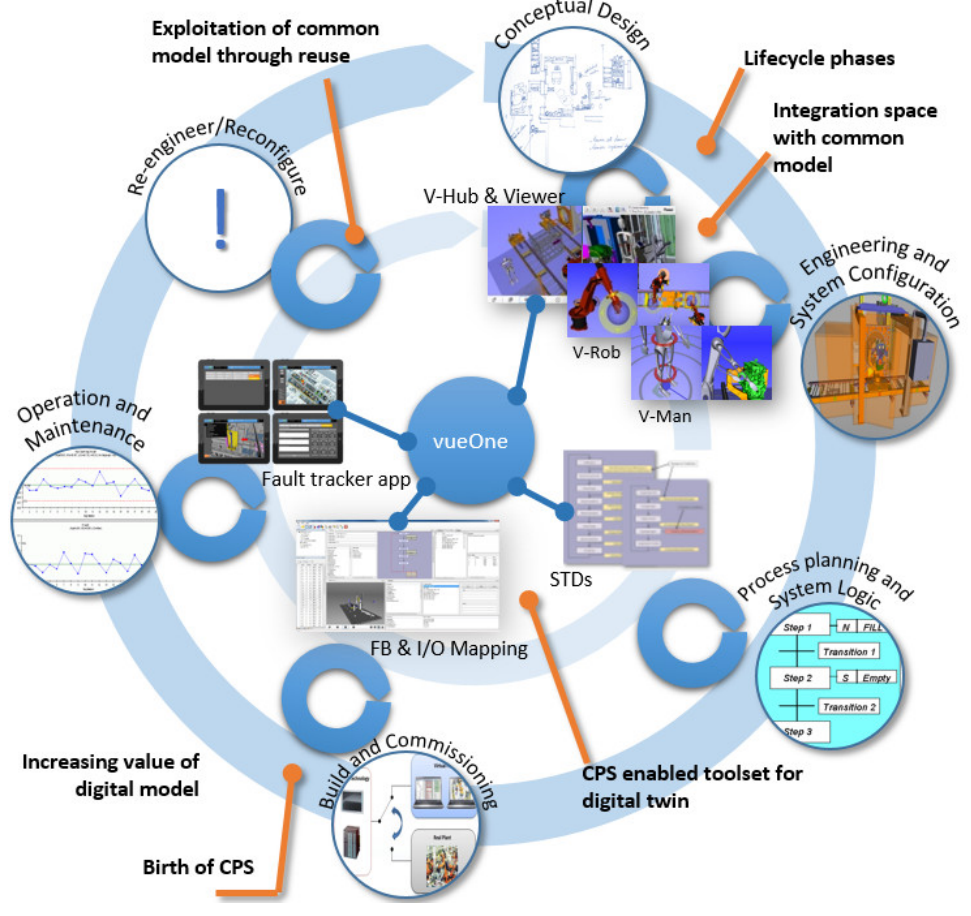
Figure 2. System lifecycle supported by the use of a common modelling framework to enable CPS